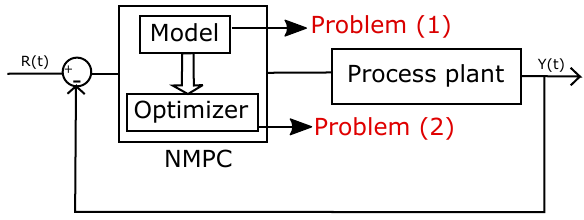
Figure 2. General representation of a